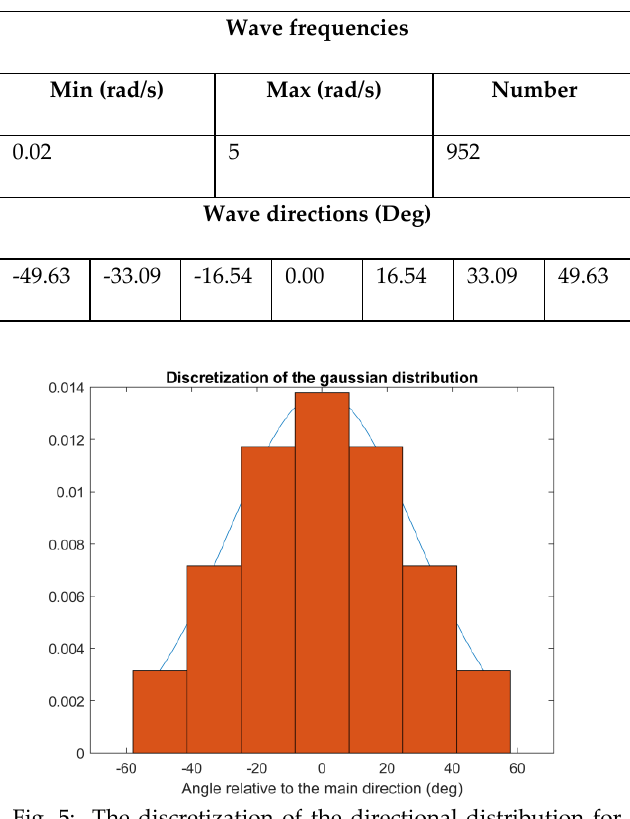
Table 2: Wave directions chosen to obtain the hydrodynamic coefficients.